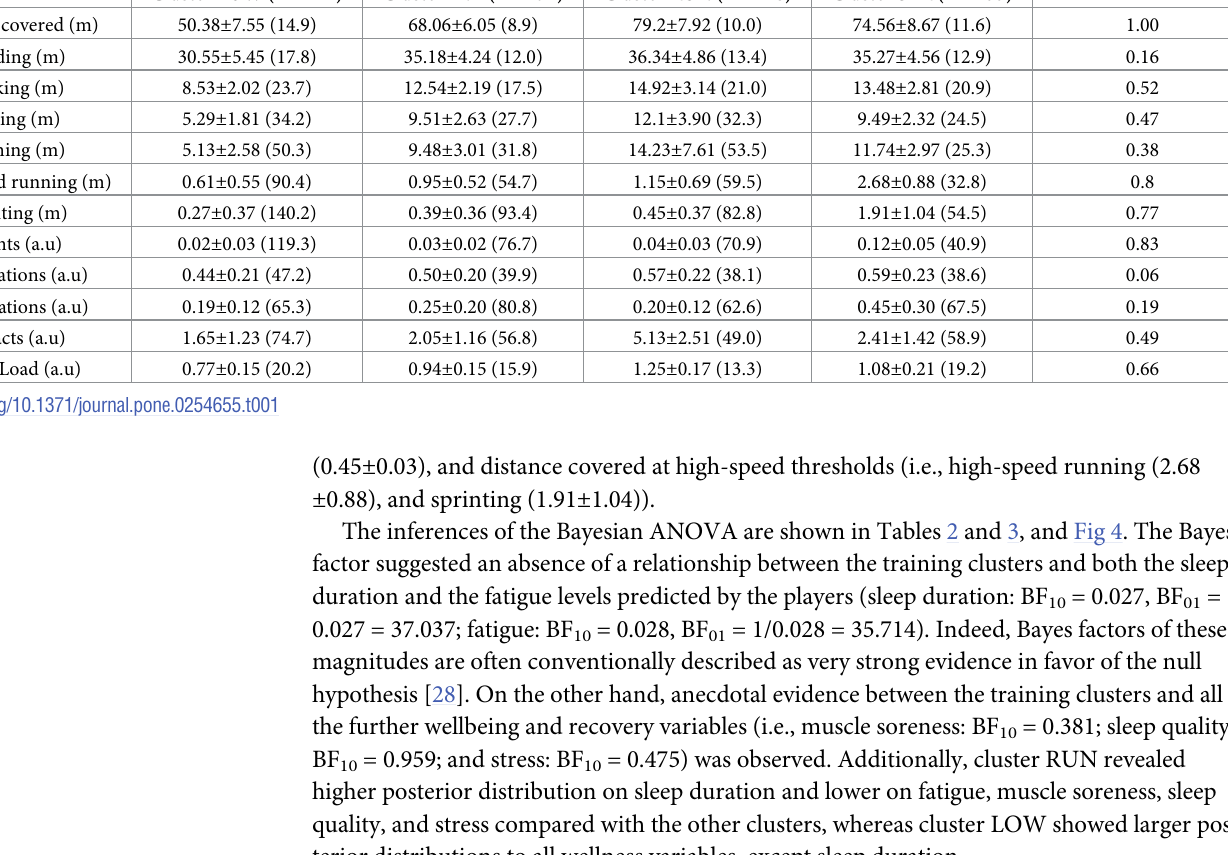
Table 1. Means, standard deviations and predictor importance from the obtained